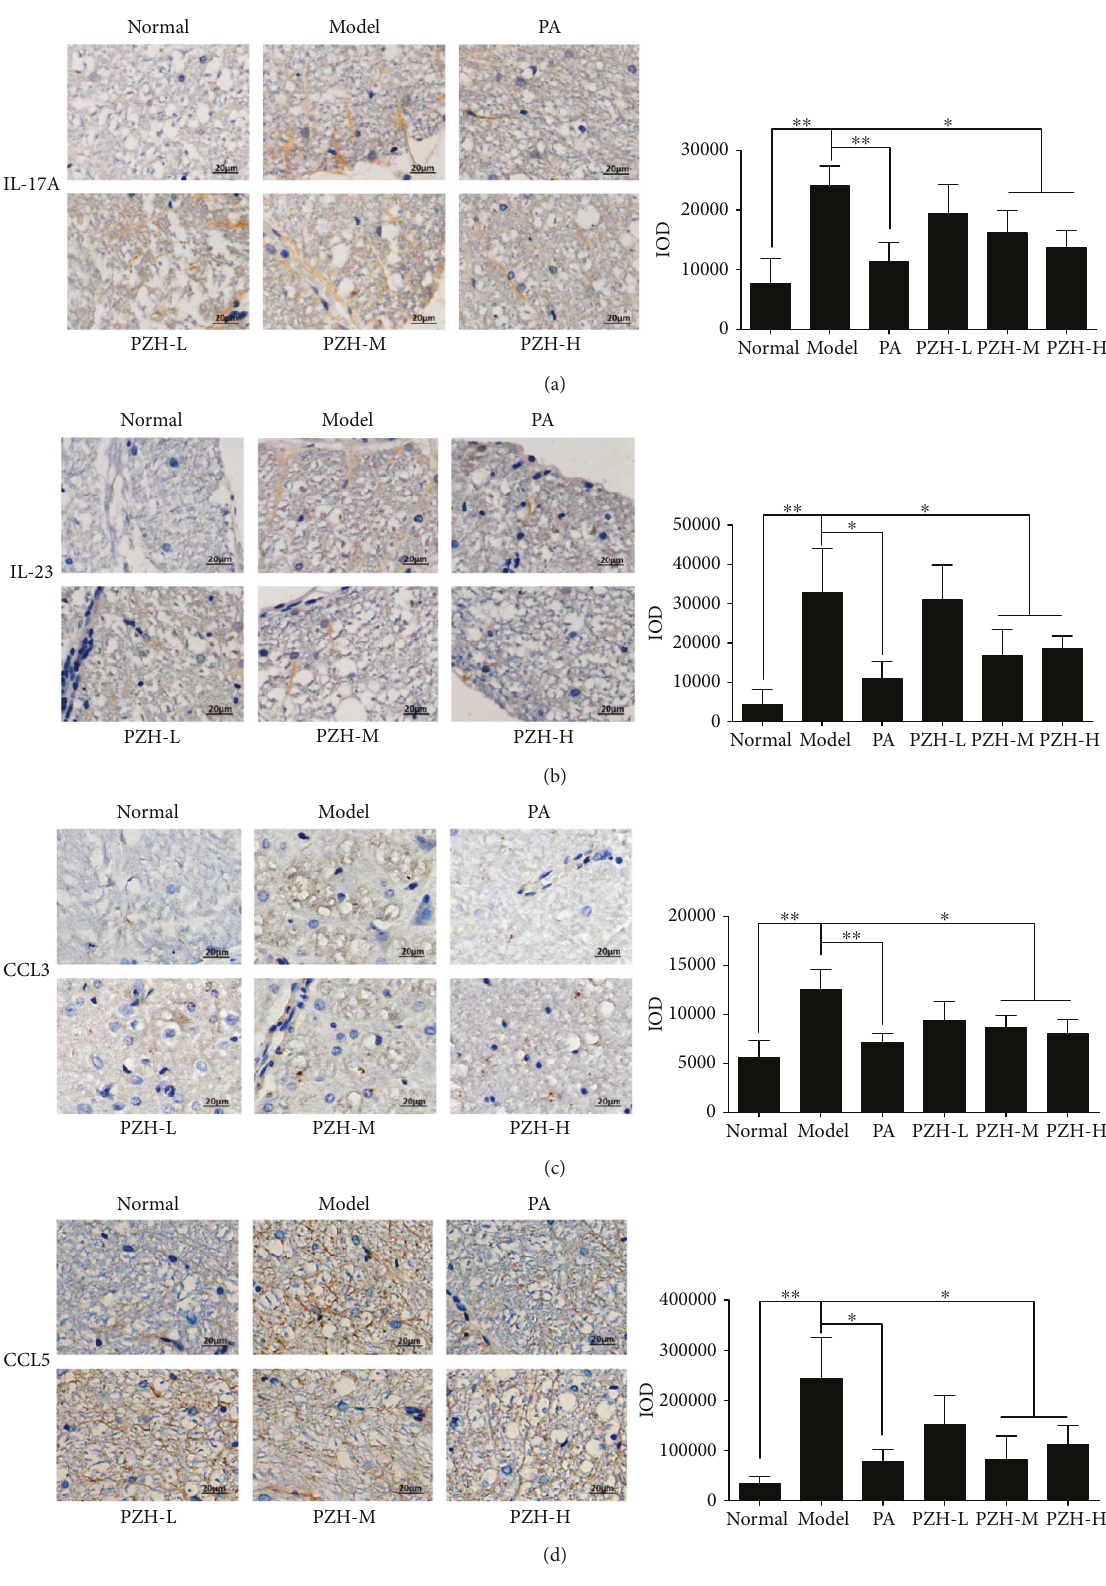
Figure 3: PZH decreased the levels of IL-23, IL-17A, CCL3, and CCL5 in the CNS of EAE rats. Representative immunohistochemistry images (left) and IOD means (right) of IL-23 (a), IL-17A (b), CCL3 (c), and CCL5 (d) in the spinal cord of rats from each group. Original magni fi cation 200x. All data were shown as the mean ± SD. ∗ P < 0 05 and ∗∗ P < 0 01